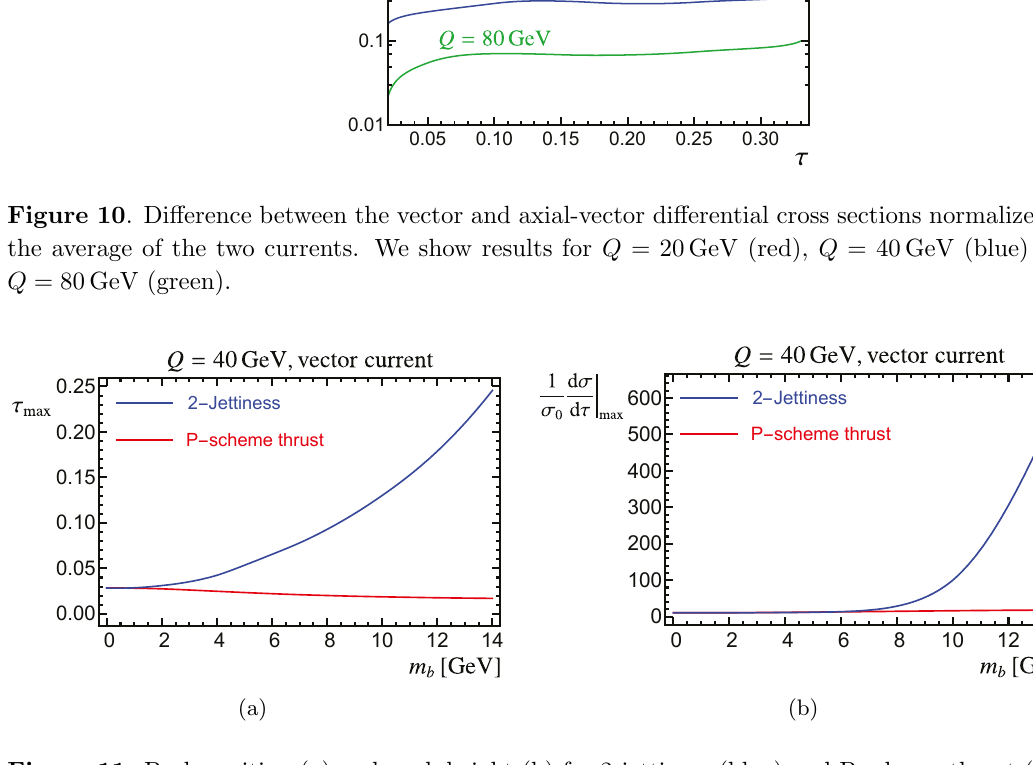
Figure 11 . Peak position (a) and peak height (b) for 2-jettiness (blue) and P-scheme thrust (red) massive cross section. Results correspond to default pro(cid:12)les, vector current and a center-of-mass energy of 40 GeV, and with m b (cid:17) m b ( m b ). We vary the bottom mass between 0 and 14 GeV, such that SCET still